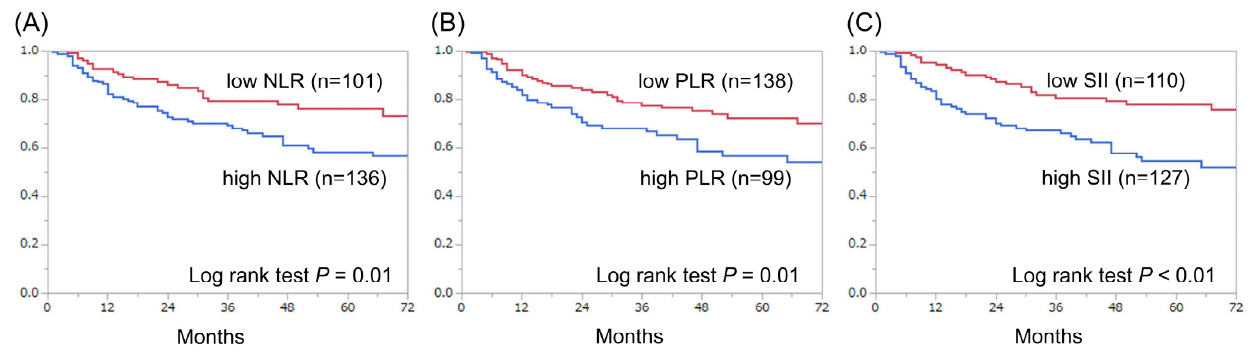
Figure 2. Kaplan–Meier curves for CSS according to preoperative NLR ( A ), PLR ( B ) and SII ( C ).